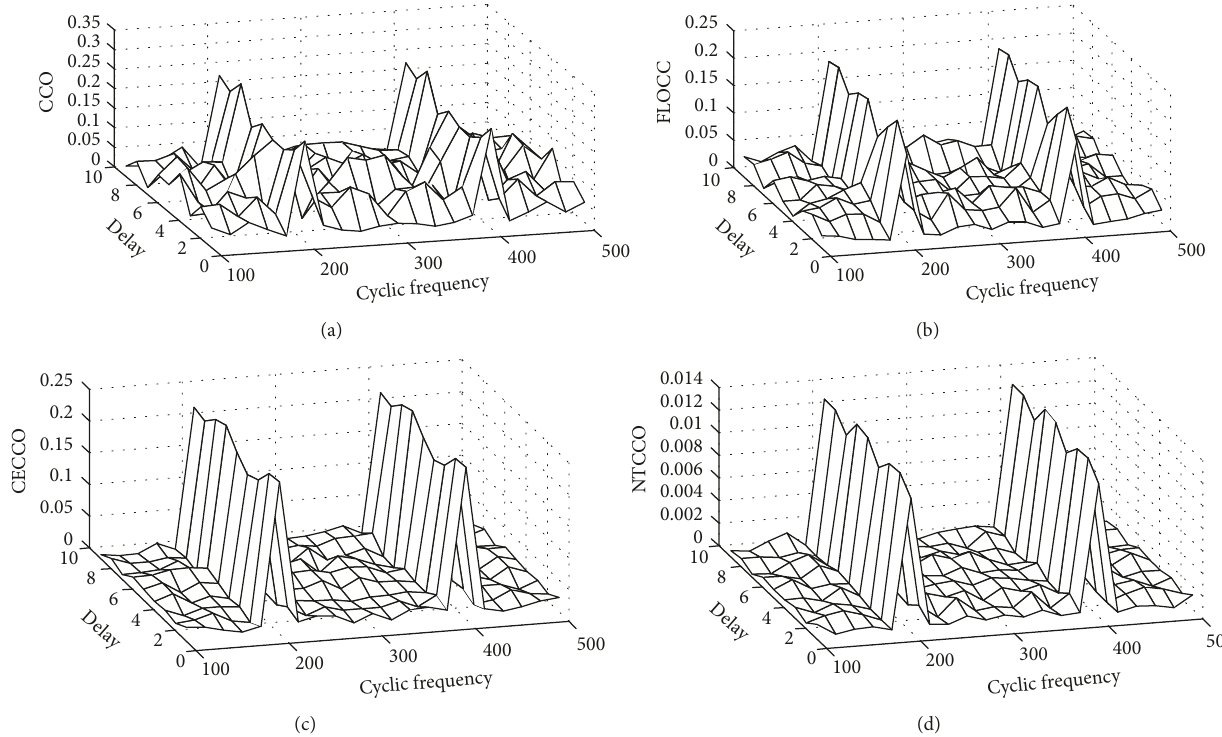
Figure 1: The CCO (a), FLOCC (b), CECCO (c), and NTCCO (d) of the two time varying AM signals under 𝛼 -stable impulsive noise